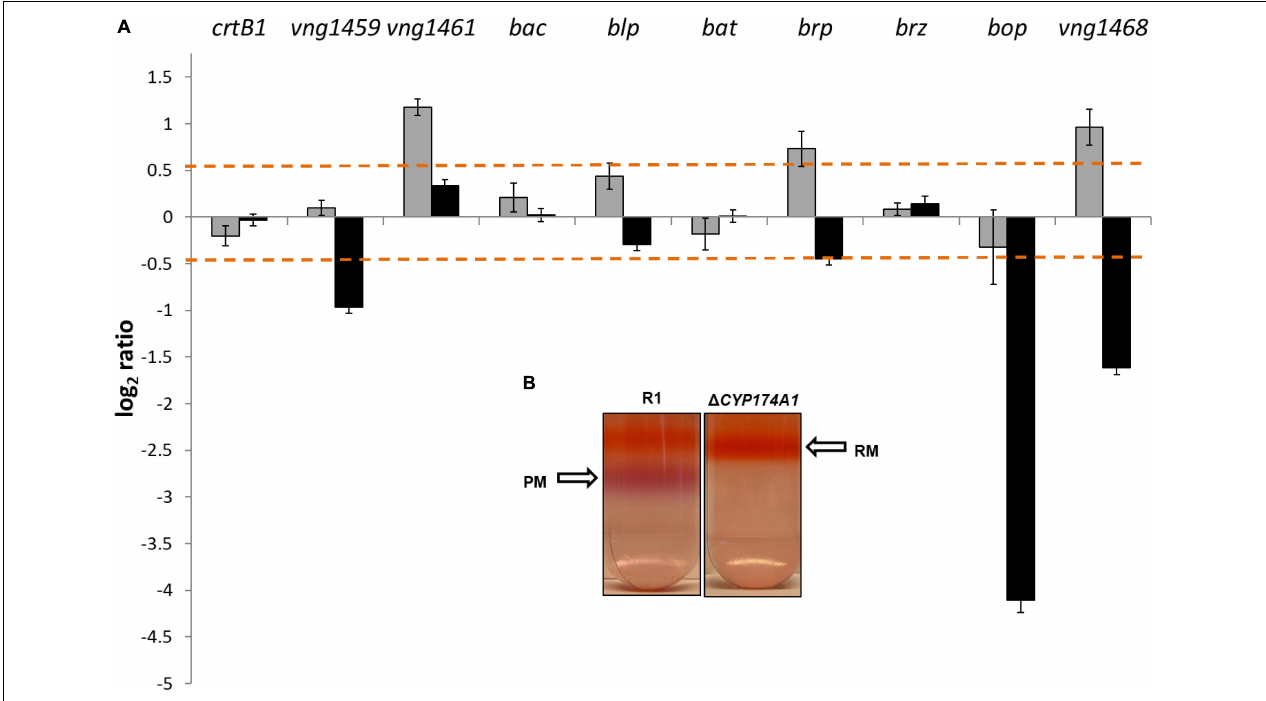
FIGURE 2 | (A) Log 2 ratios ( y -axis) are shown for expression profiles in logarithmic (gray bars) and stationary growth phases (black bars) for the H. salinarum R1 parental and (cid:49) CYP17 4 A1 strains. Dashed lines indicate the threshold of significant differential expression (see Materials and Methods) and error bars indicate standard errors. (B) inlet: H. salinarum R1 parental strain and (cid:49) CYP17 4 A strain red membrane (RM) and purple membrane (PM) as fractionated by sucrose